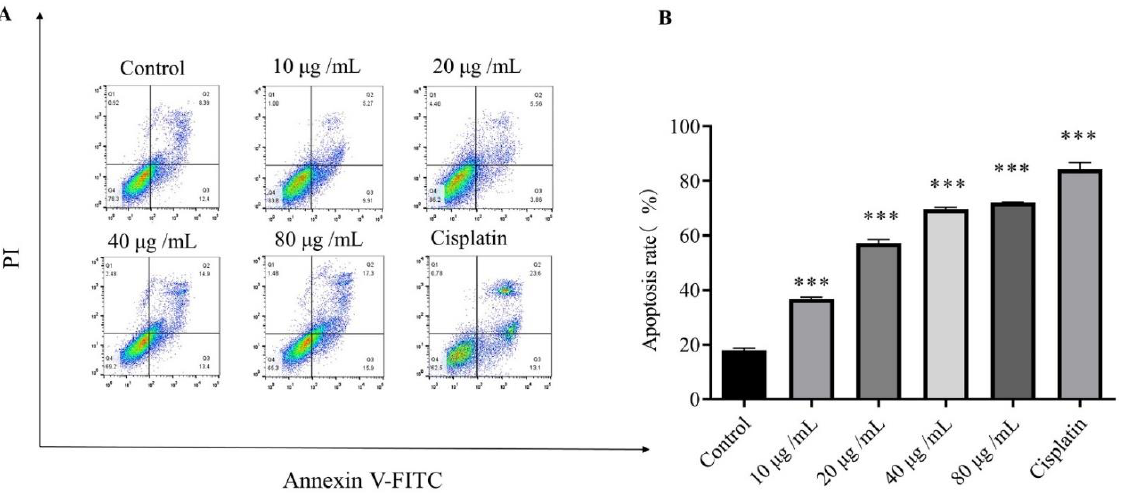
Figure 3. Effect of HSF on apoptosis of MCF-7 cells. Annexin V-FITC and PI staining were detected by flow cytometry. ( A ) Flow cytometry for the analysis of cell apoptosis. ( B ) Apoptosis rate. *** p < 0.001 vs. control group.